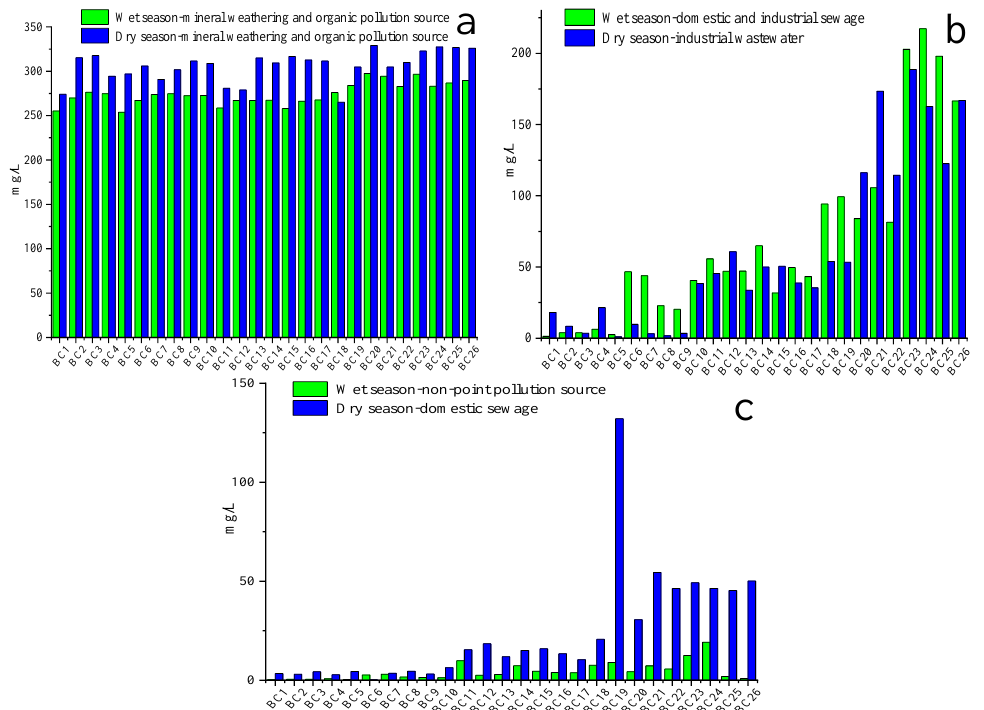
Figure 3. Estimated contributions (mg / L) from each source (mineral weathering and organic pollution source in the wet and dry seasons ( a ), domestic and industrial sewage in the wet season and industrial wastewater in the dry season ( b ), non-point pollution source in the wet season and domestic sewage in the dry season ( c )) at the sampling sites obtained by the PMF model.